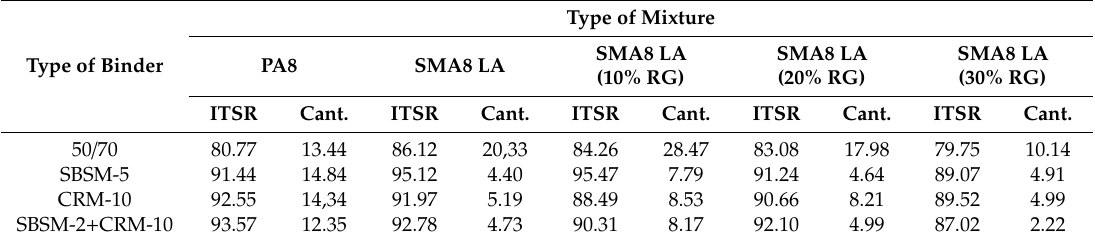
Table 4. Test results of water damage susceptibility and Cantabro abrasion loss